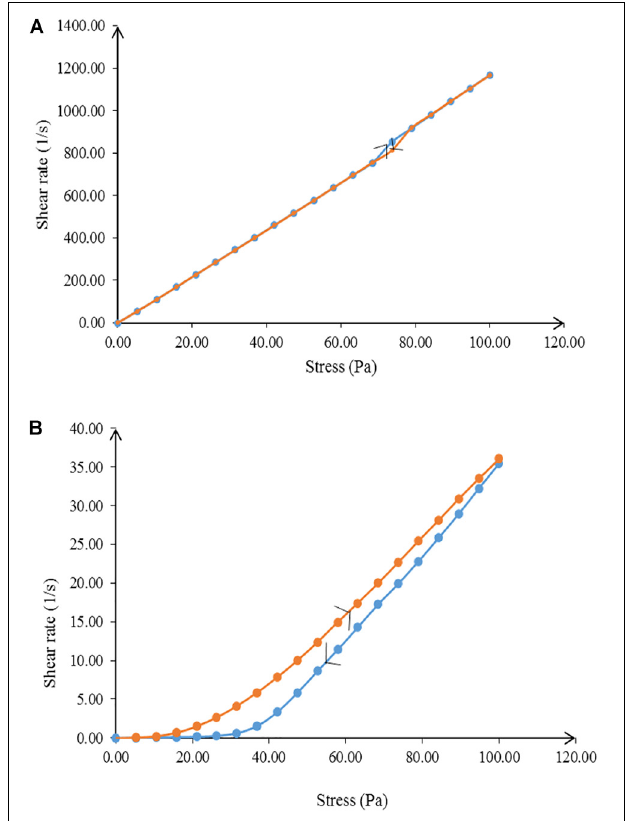
FIGURE 5 | Flow behavior of (A) NT 6 and (B) NT 11 from 0.00 to 100 Pa and from 100 to 0.00 Pa shear